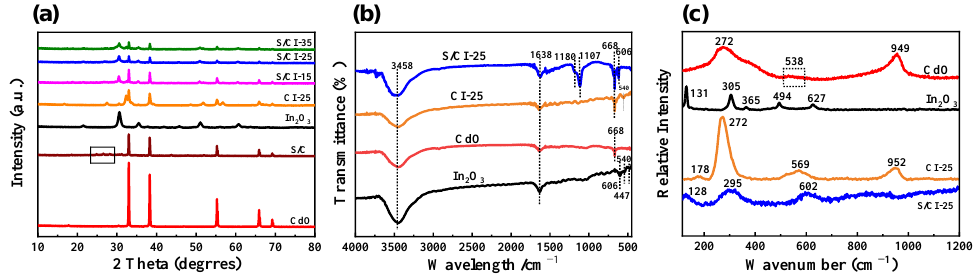
Figure 2. ( a ) XRD patterns, ( b ) FTIR spectra, and ( c ) Raman spectra of synthesized samples.